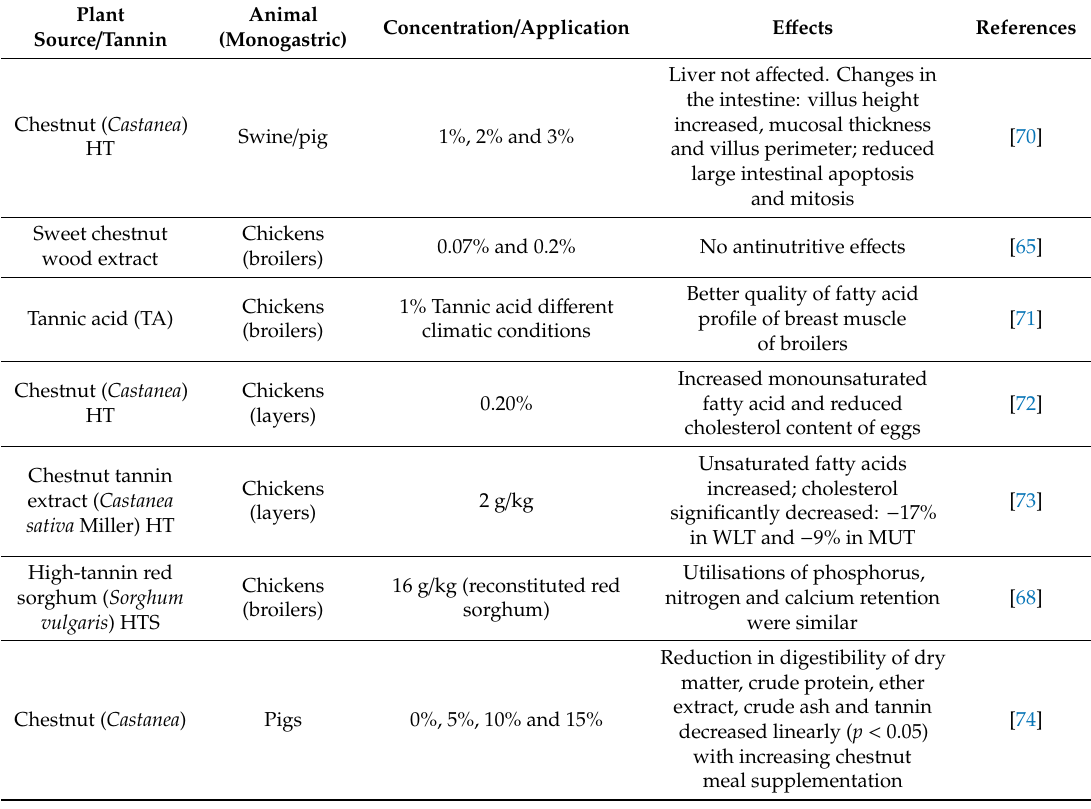
Table 3. Nutritive and antinutritive e ff ects of tannins in monogastric